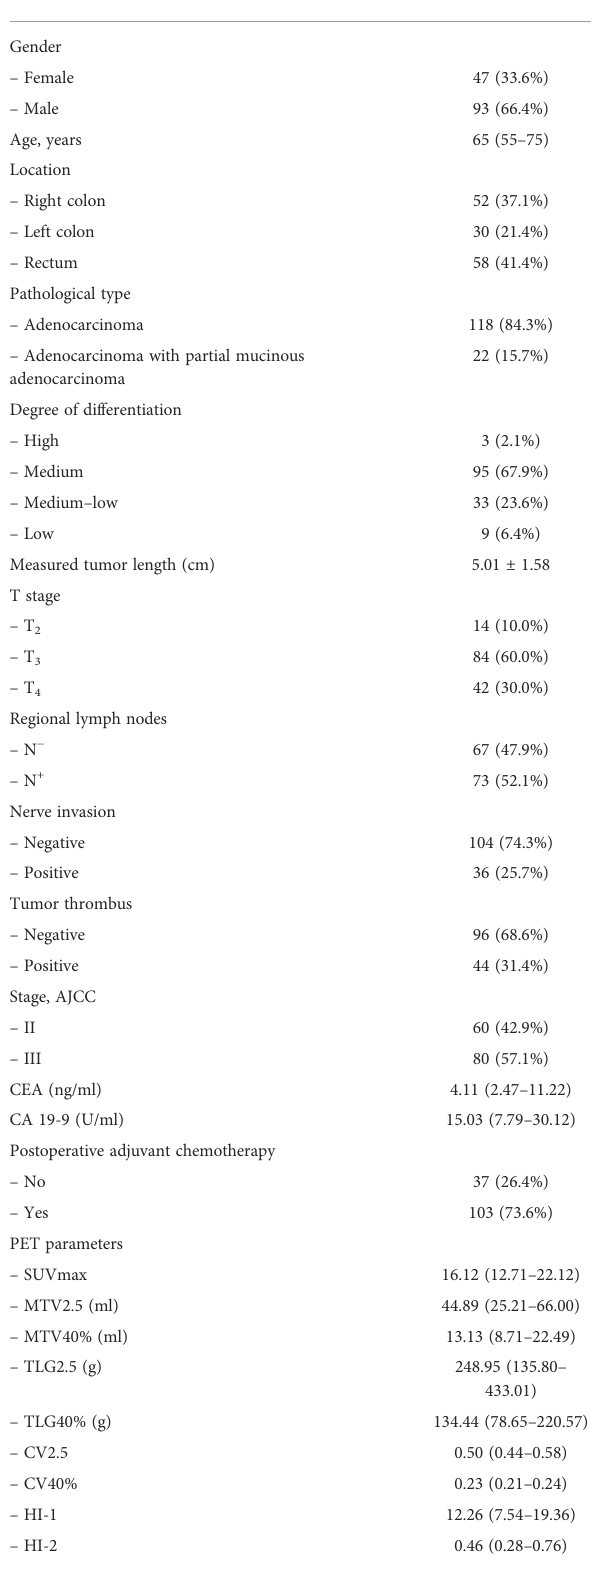
TABLE 1 Baseline characteristics and PET parameters of the